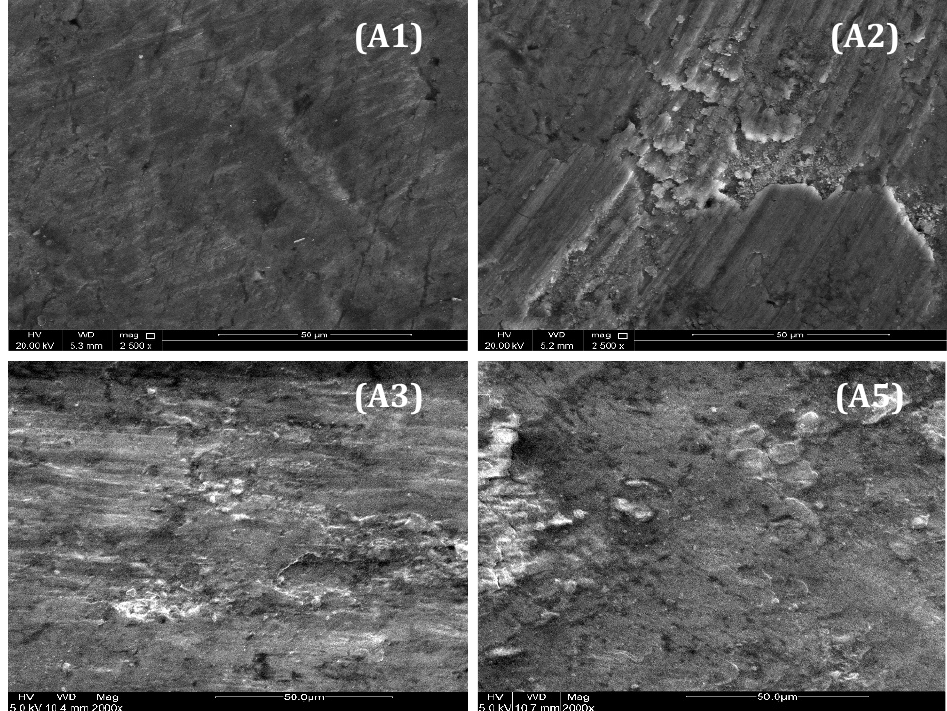
Figure 11. Fracture surface images of the ( A1 ) pure Al, ( A2 ) Al/5SiC, ( A3 ) Al/5SiC/3TiO 2 , and ( A5 ) Al/5SiC/9TiO 2 hybrid nanocomposites.